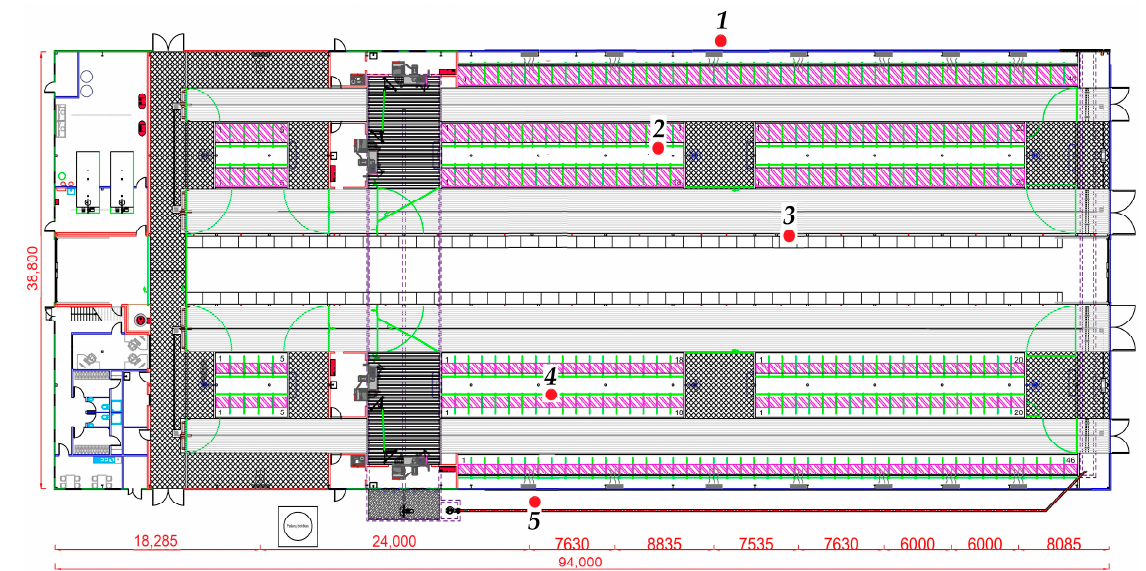
Figure 3. The scheme of placement of PeakTech P 5185 data loggers (1–5) in a cowshed. The climate comfort was determined using the temperature and humidity indices (temperature humidity index— THI ) [4,11–13]. THI was calculated using the equation: